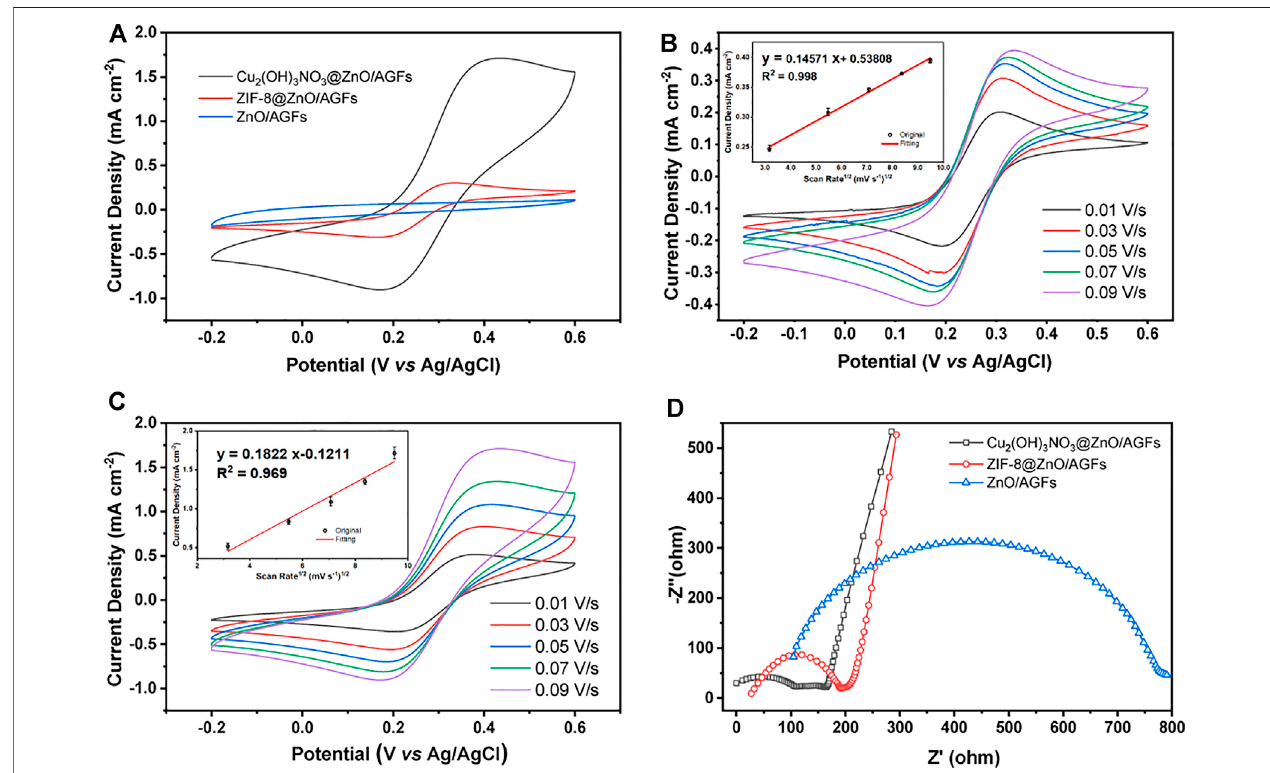
FIGURE4|(A) CVcurvesofdifferentmicroelectrodesin0.1 MKClsolutioncontaining5.0 mM[Fe(CN) 6 ] 3 − /4 − .Scanrate:0.09 V s − 1 .CVmeasurementsof (B) ZIF- 8@ZnO/AGF and (C) Cu 2 (OH) 3 NO 3 @ZnO/AGF are performed with [Fe(CN) 6 ] 3 − /4 − as the redox probe at different scan ratesfrom 0.01 to0.09 V s − 1 . (D) Nyquistplots of ZnO/AGF, ZIF-8@ZnO/AGF, and